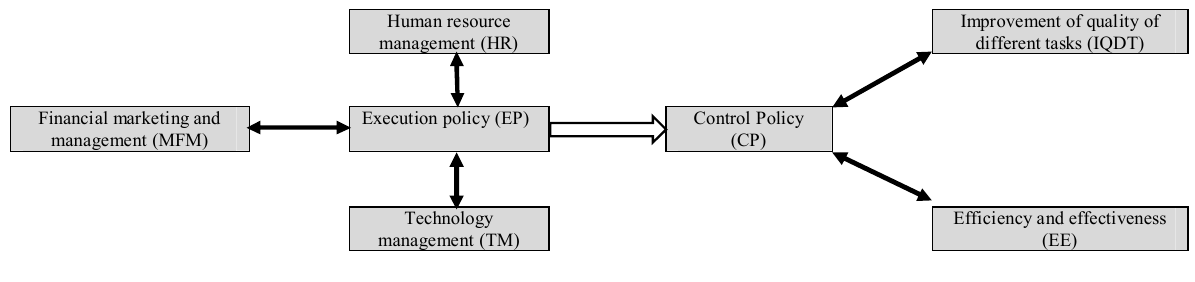
Fig. 1. The proposed